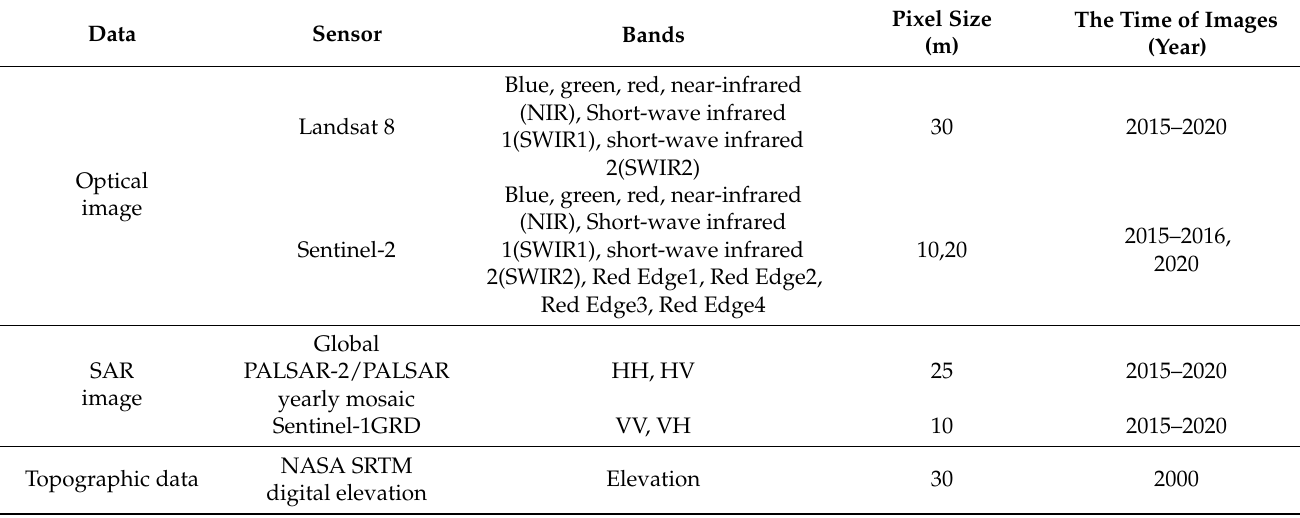
Table 1. Parameters of remote sensing images required for mapping in the current